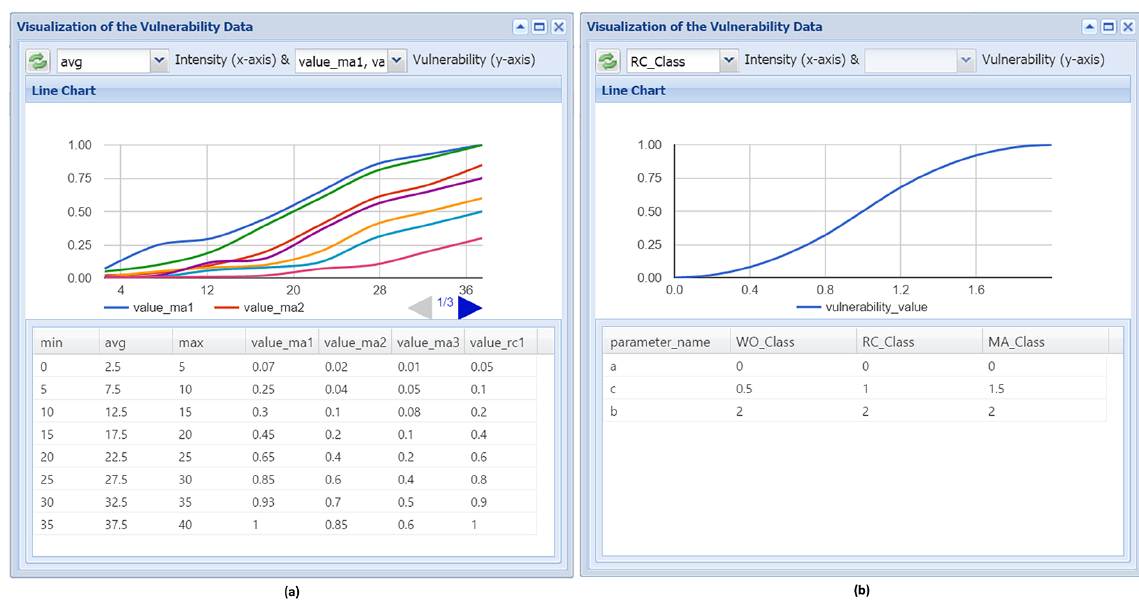
Figure 12. (a) Visualization of the vulnerability curves generated using data ranges. The curves are drawn based on the average intensity values for different building material types such as masonry 1 floor, reinforced concrete 1 floor, etc. (b) Visualization of the vulnerability curve generated using the CDF. The curve is drawn based on Eq. (2) for the building material type (e.g. reinforced concrete). The input parameter values a , b and c are given by the